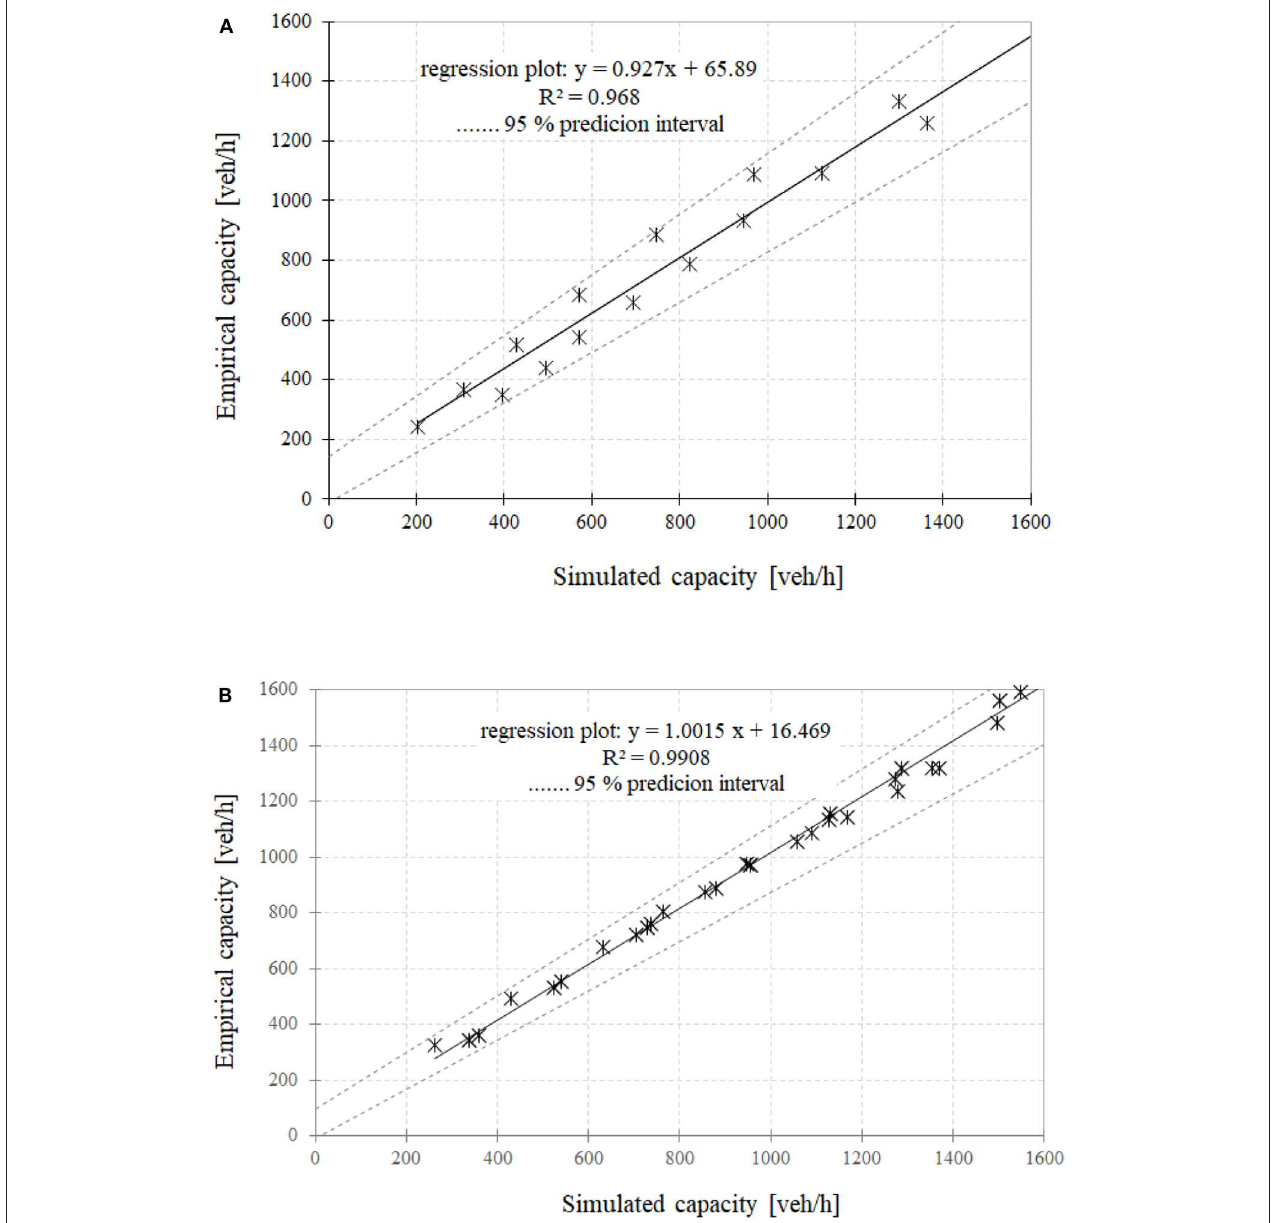
FIGURE 6 | Empirical vs. simulated capacity for maneuvers with similar entry mechanism: (A) two entry lane and two circulating lanes; (B) one entry lane and one circulating lane.